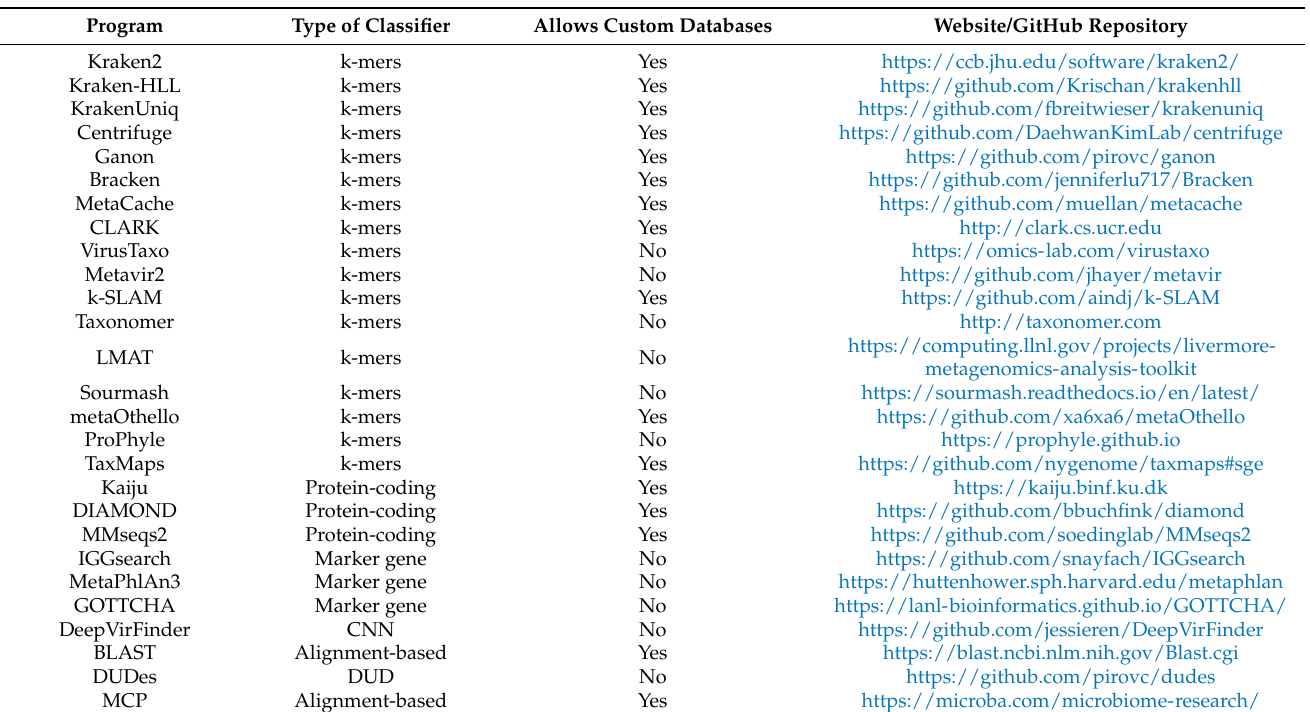
Table 6. Bioinformatic taxonomic profilers, including algorithm, use of custom databases, and website or GitHub repository. All websites/GitHub Repository links were accessed on 23 December